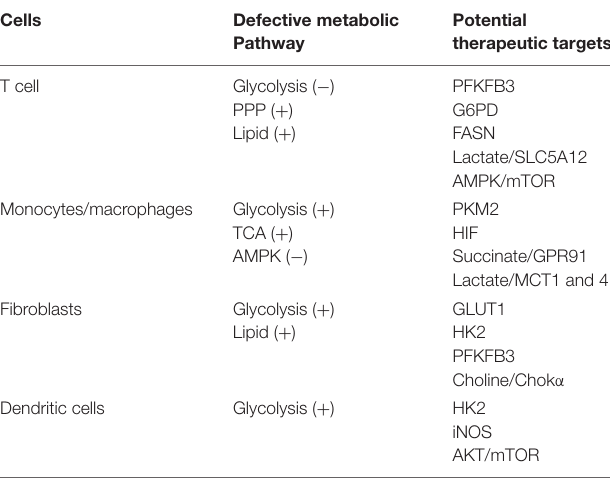
TABLE 1 | Potential metabolic therapeutic targets in